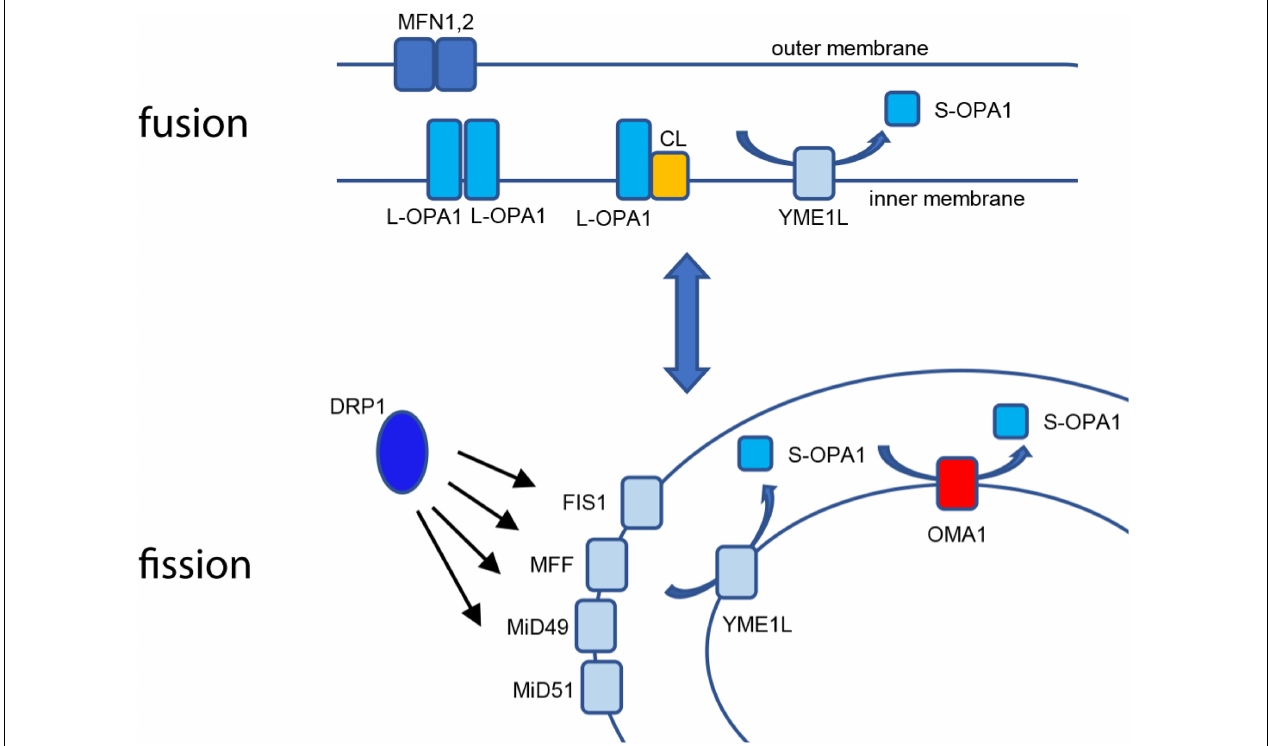
FIGURE 1 | Mitochondrial fusion and fission. Fusion of the mitochondrial outer membrane is carried out at MFN1 and 2, while L-OPA1 maintains continuity of the inner membrane, either by homotypic interaction or by binding cardiolipin (CL). YME1L constitutively cleaves L-OPA1, resulting in basal S-OPA1. Fission is mediated by recruitment of cytosolic DRP1 to the outer membrane using actin-dependent dynamics, where it is bound by mitochondrial binding partners FIS1, MFF, MiD49, and MiD51. When activated, OMA1 cleaves L-OPA1 to S-OPA1 in cooperation with YME1L for accumulation of fusion-inactive S-OPA1.